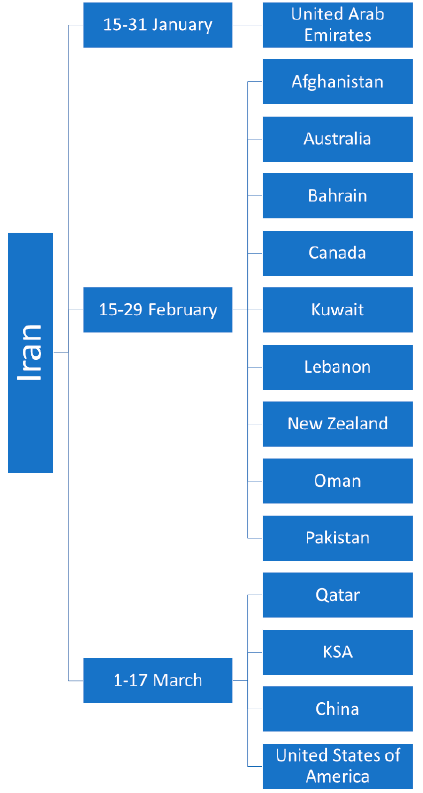
Figure 3. Time periods of imported cases from Iran to other countries.